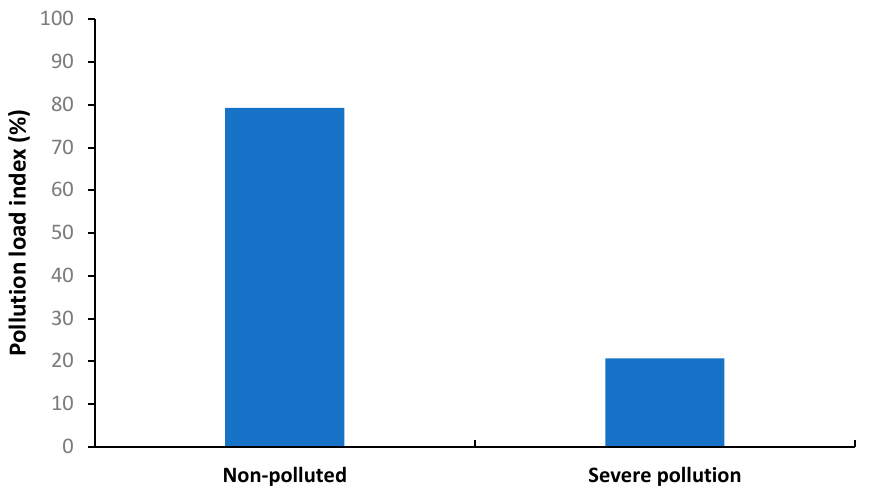
Figure 4. Distribution of the market gardens of Lubumbashi according to their pollution load index.